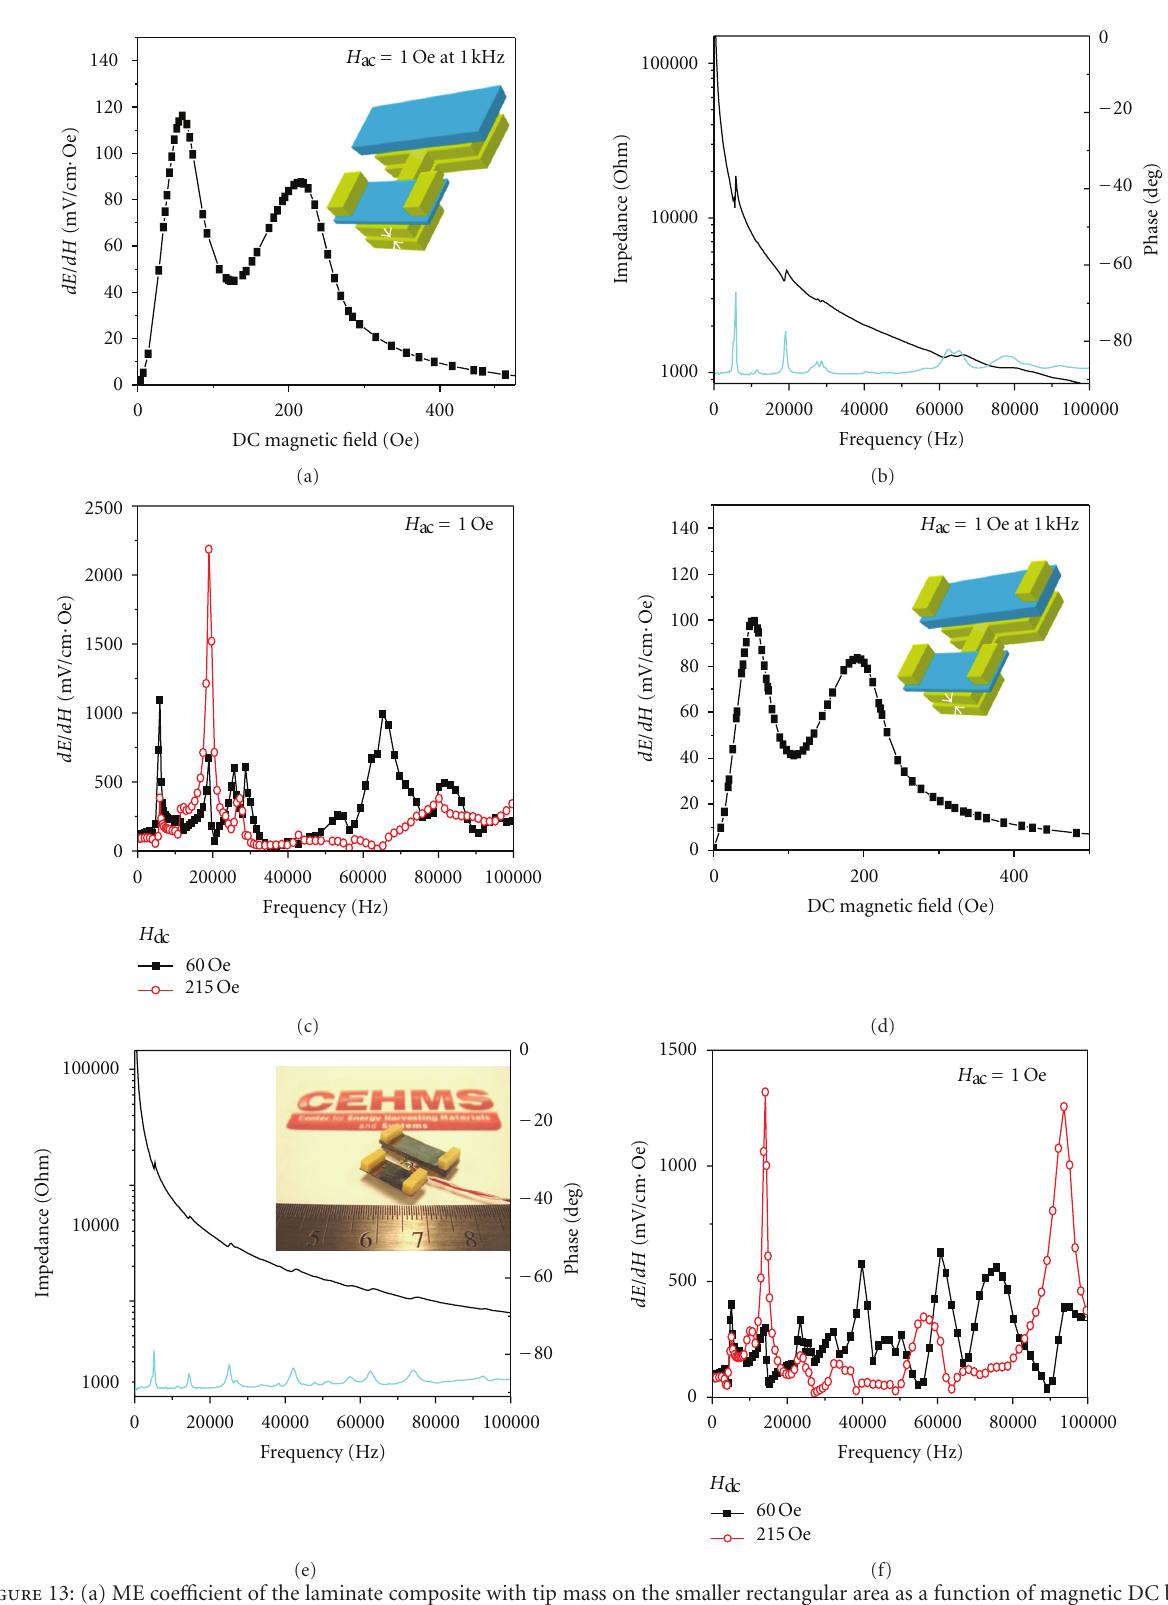
Figure 13: (a) ME coe ffi cient of the laminate composite with tip mass on the smaller rectangular area as a function of magnetic DC bias at 1kHz, (b) impedance and phase spectrums with tip mass on the smaller section as a function of frequency, (c) ME sensitivity with tip mass on the smaller section as a function of frequency, (d) ME coe ffi cient of the laminate with tip mass on both smaller and larger rectangular sections, (e) impedance and phase spectrums with tip mass on both sections, and (f) ME sensitivity as a function of frequency with tip mass on both sections